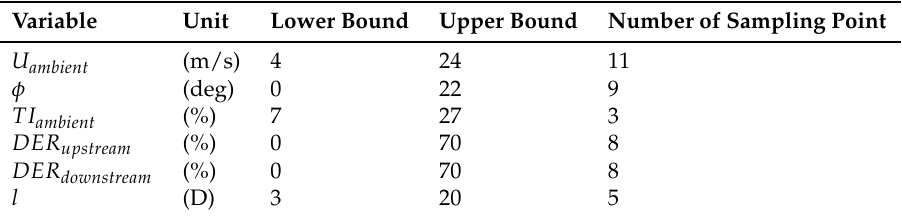
Table 1. Summary of input variables, bounds and numbers of sampling points. Variable Unit Lower Bound Upper Bound Number of Sampling